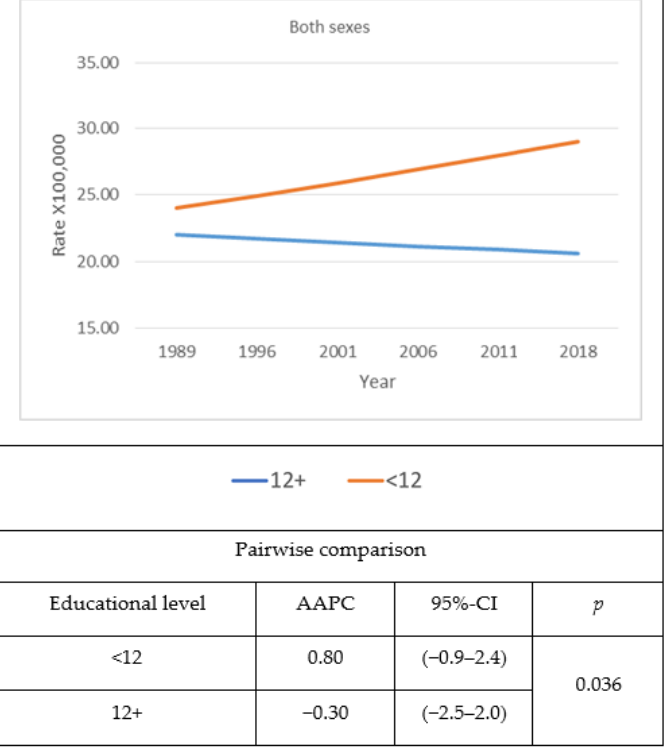
Figure 2. Time trend of age- and sex-adjusted diabetes mortality and average annual percent change (AAPC) among Hispanic males in the USA by education level and year from 1989 to 2018. The 2000 USA Census Population was used as standard.